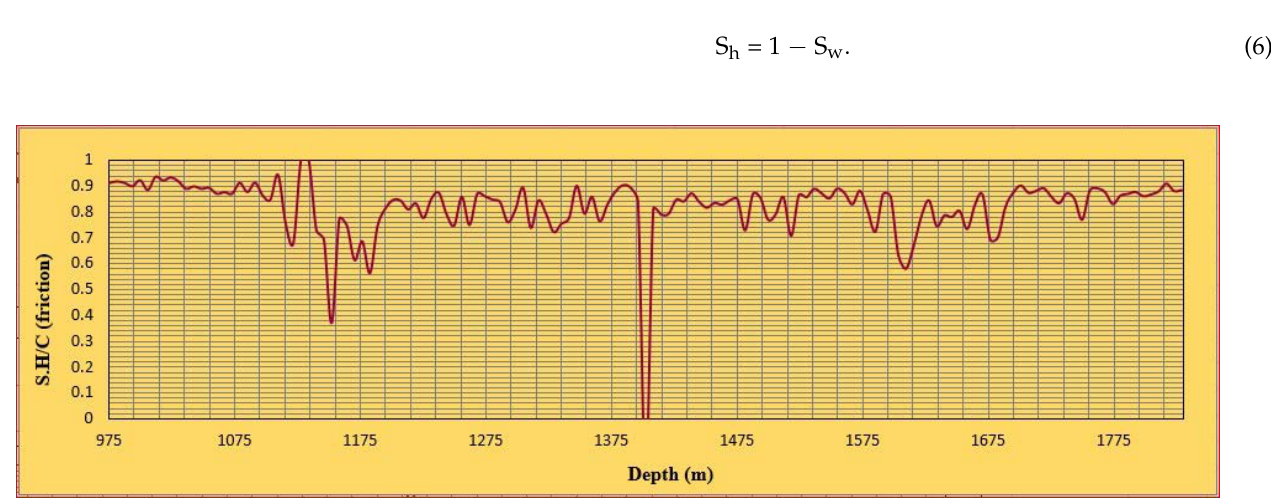
Figure 22. Hydrocarbon saturation along the depth.